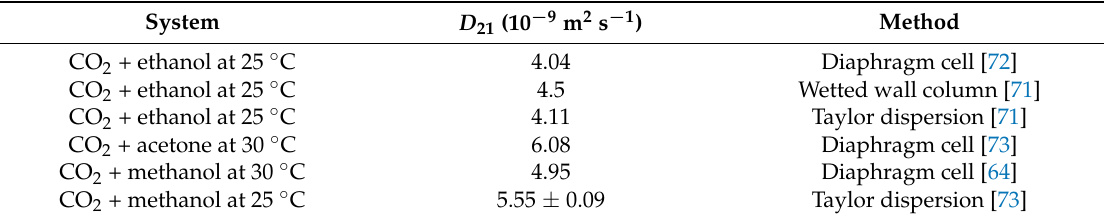
Figure 10. Diffusion coefficients of CO 2 in methanol and ethanol at infinite dilution as a function of temperature. Adopted with permission from [64,71]. Copyright (2017) American Chemical Society. Table 3. Literature data on binary diffusion coefficient of various systems at infinite dilution.